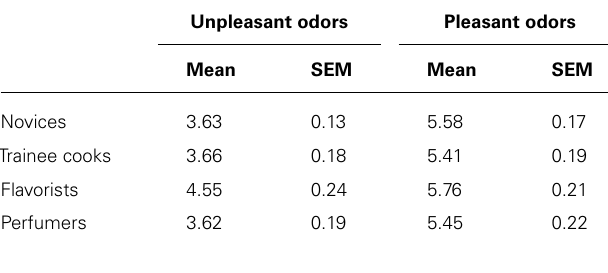
Table 1 | Pleasantness ratings of pleasant and unpleasant odors in novice (untrained) subjects, trainee cooks, flavorists, and perfumers. Unpleasant odors